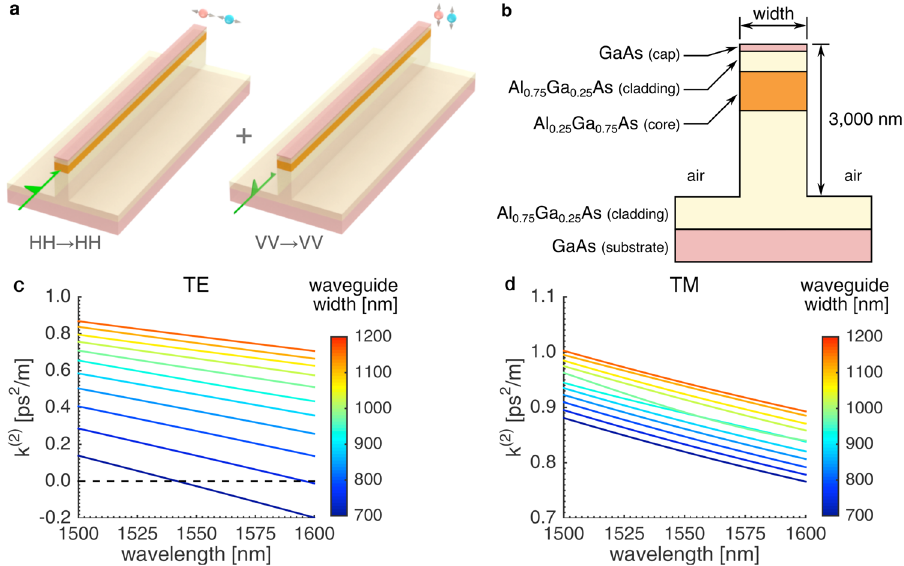
Figure 1. ( a ) The two orthogonally pumped SFWM processes that drive the entanglement generation. ( b ) A cross section of a deeply etched AlGaAs polarization-entangled photon pair source, detailing the materials composing the structure. ( c ) and ( d ) The dispersion coefficients k (2) of the TE and TM waveguide modes. The zero-dispersion wavelength near 1,550 nm is achieved for the TE mode of the waveguide width of 700